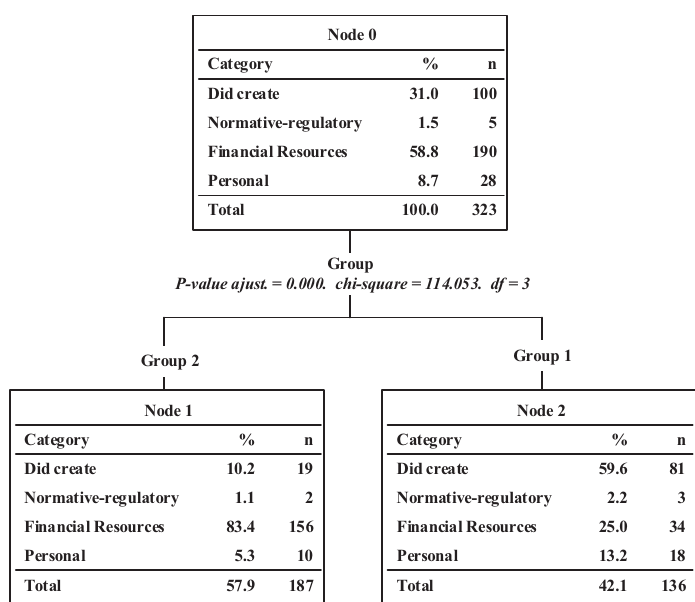
Figure 2. CHAID diagram of relationship between the Barriers and the